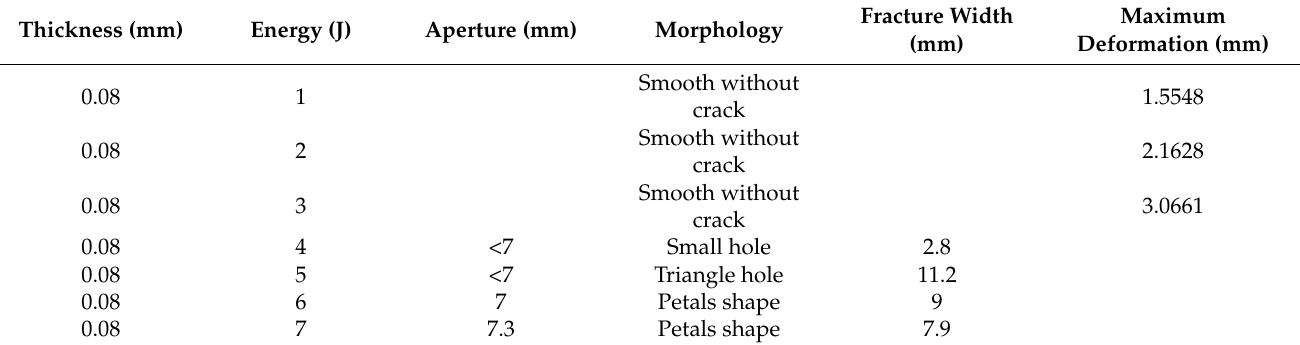
Figure 5. ( a ) The outline of targets with different impact times. ( b ) The morphologies of target material with different impact times. Table 4. Measurement of experimental data of different impact